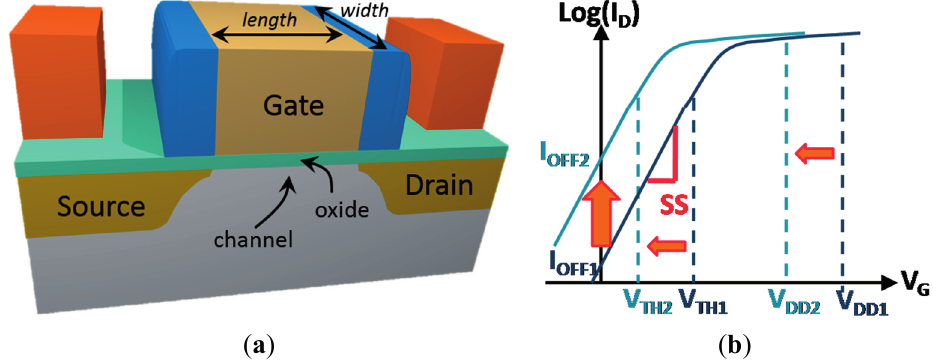
Figure 2. Schematic illustrations of the MOSFET ( a ) structure, ( b ) transfer characteristics (output current I D vs . input voltage V G ). If the operating voltage ( V DD ) is to be reduced, then the threshold voltage ( V TH ) should be reduced ( i.e. , the I - V curve should be shifted to the left) to maintain the same peak level of ON-state current, but this would result in an exponential increase in OFF-state leakage current ( I OFF